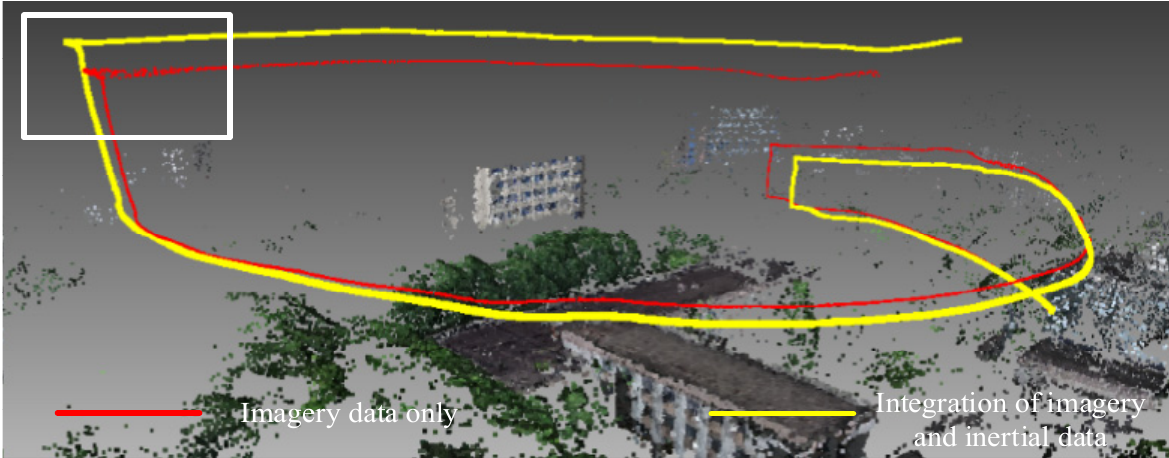
Figure 5. Comparison of the proposed method and SfM only using imagery data. Yellow line is the trajectory estimated by the proposed method and red line is estimated by imagery data only. The two trajectories are registered